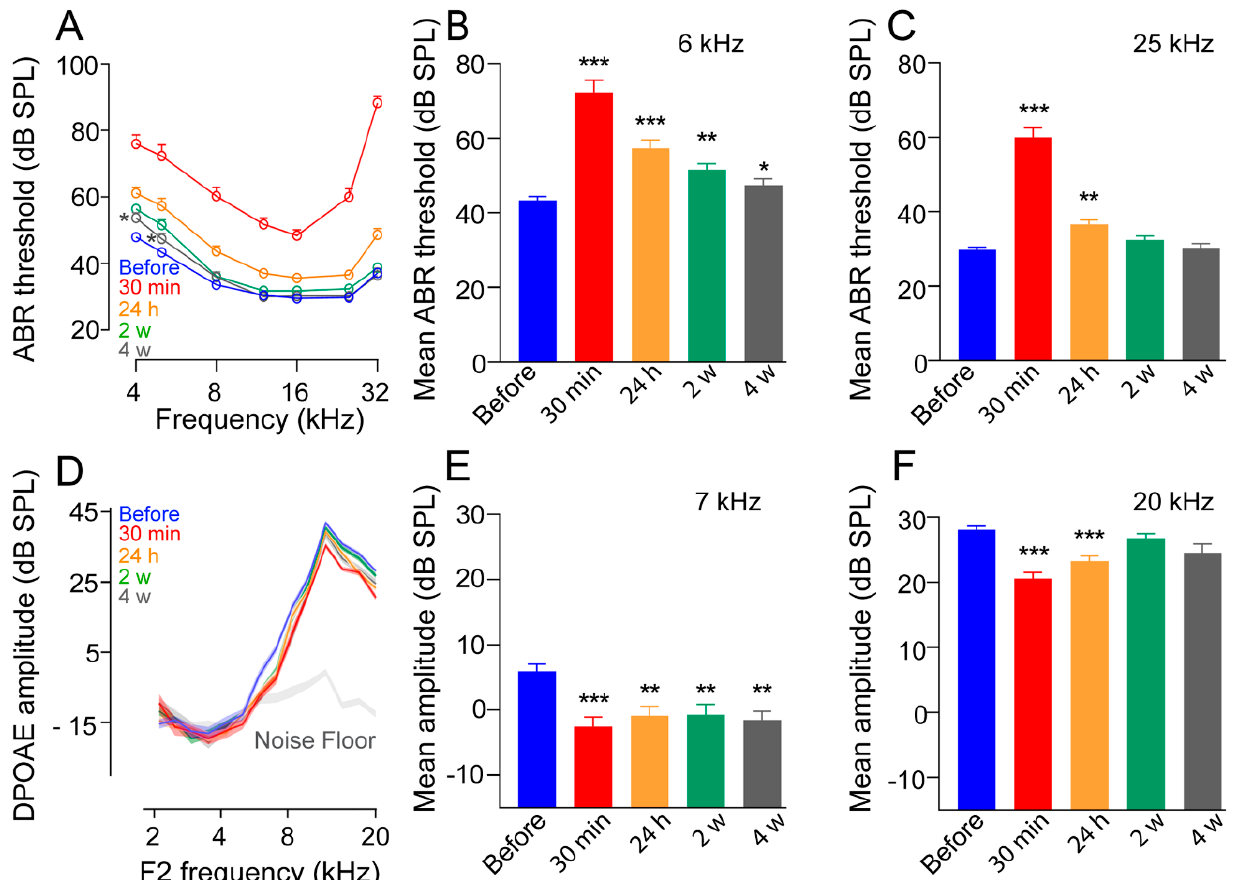
Figure 2. Broad-spectrum impulse noise-induced temporary threshold shift. ( A , D ): ABR thresholds ( A ) and DPOAE amplitude ( D ) recorded before (blue) and 30 min (red), 24 h (orange), 2 weeks (green), and 4 weeks (gray) after impulse-noise exposure. Note complete recovery of ABR thresholds and DPOAE amplitude in the higher-frequency regions (8 to 32 and 8 to 20 kHz, for ABR and DPOAE, respectively) by 2 and 4 weeks after exposure. ( B , C ): Mean ABR thresholds at 6 to 32 kHz for all evaluation time points. ( E , F ): Mean DPOAE amplitudes at 6 to 32 kHz for all time points. All data are expressed as mean ± SEM ( n = 22 cochleae per time point); two-way ANOVA test was followed by Dunnett’s multiple comparison: * p ≤ 0.05, ** p ≤ 0.01, *** p ≤ 0.001, time after noise exposure vs . before.